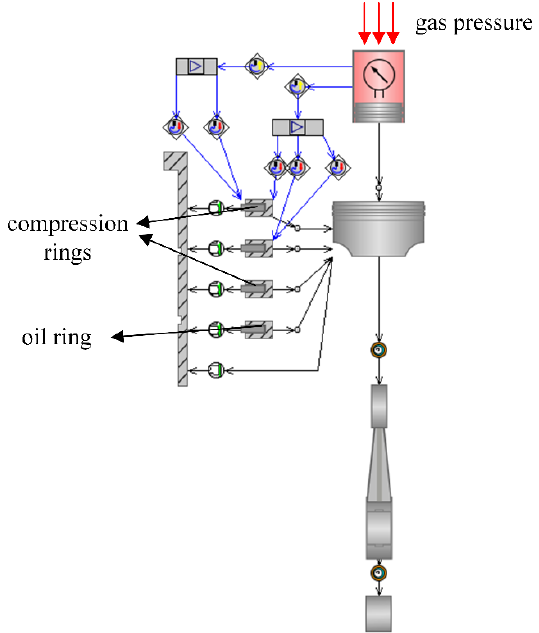
Figure 2. Mechanical model of piston-connecting rod group.